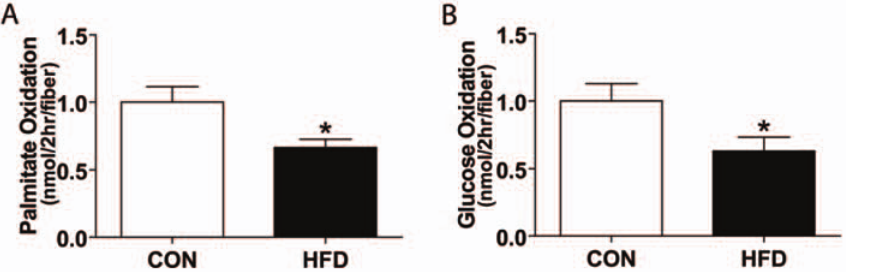
Figure 3. Impaired palmitate and glucose oxidation in HFD single fibers. (A) Palmitate (N=19, average of 17 fibers/dish) and (B) glucose (N=12 CON, N=10 HFD, average of 23 fibers/dish) oxidation in single fibers derived from EDL and peroneus muscles was similarly impaired in mice fed a high-fat diet (HFD) compared to control (CON). Values were normalized to control values for each experiment and significance is represented by * vs. CON, p , 0.005.